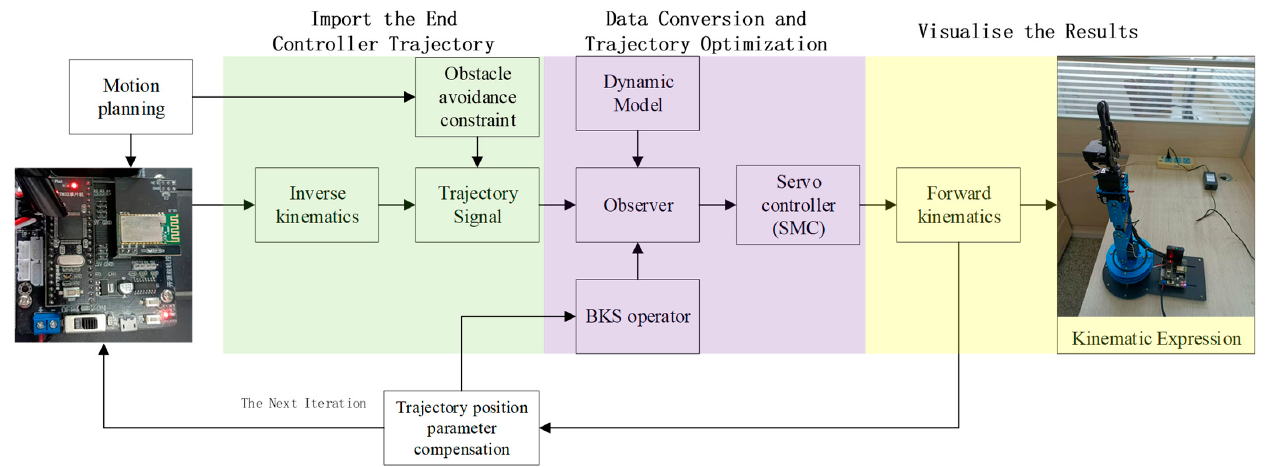
Figure 9. The control block of the robot manipulator servo control scheme proposed in this paper.